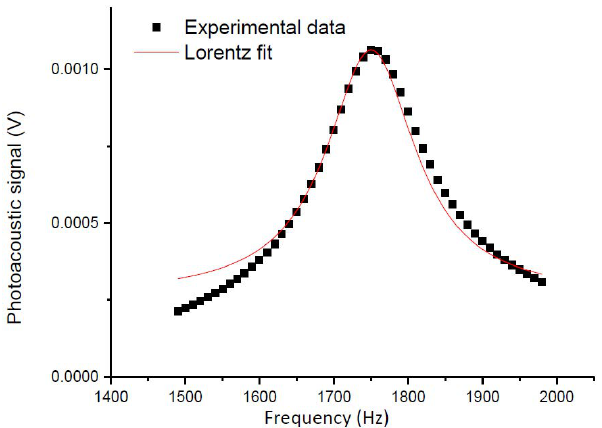
Figure 6. Photoacoustic signal under di ff erent modulation frequencies, from 1.5 to 2 kHz, when the laser wavelength was set at 1531.68 nm in the absorption line of NH 3